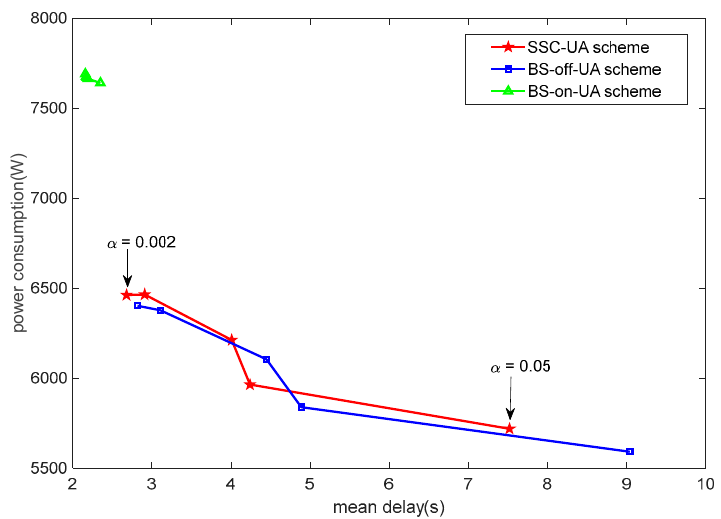
Figure 10. Comparison of average latency and total energy consumption of the three schemes.